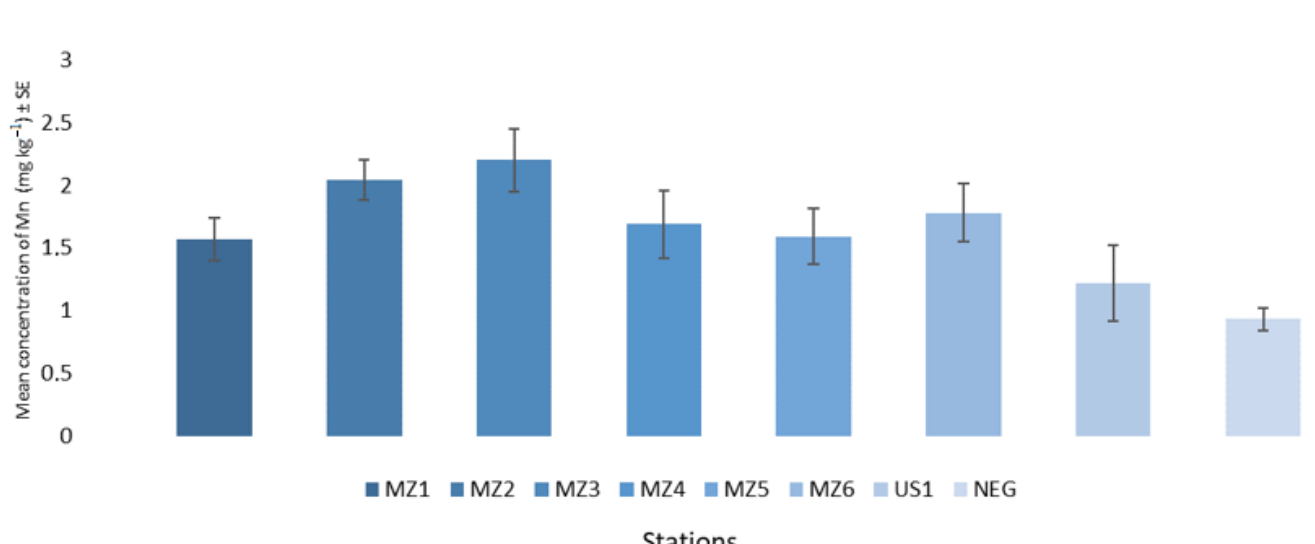
6 of 12 Table 2. The ranges, mean values, and standard errors of Mn concentrations measured on each control station in the DSP positive samples. Station Name